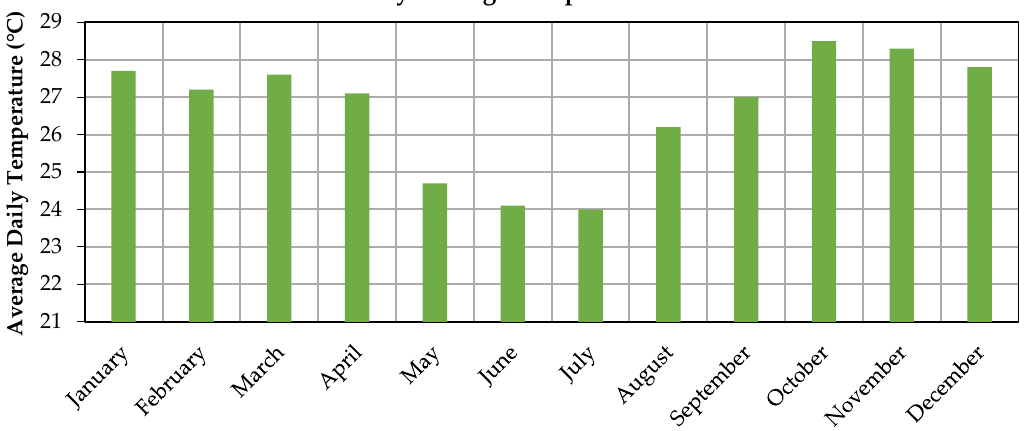
Figure 3. Monthly average temperature data, Tacuaral de Mattos,